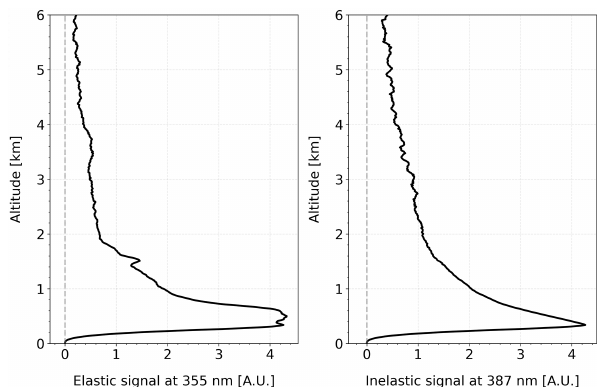
Figure 6. The synthetic elastic and inelastic signal profiles at 355 and 387nm, respectively, that were used as an input in the eVe soft- ware. The signals are range-corrected and vertically smoothed with a first-order polynomial fit and a smoothing window of